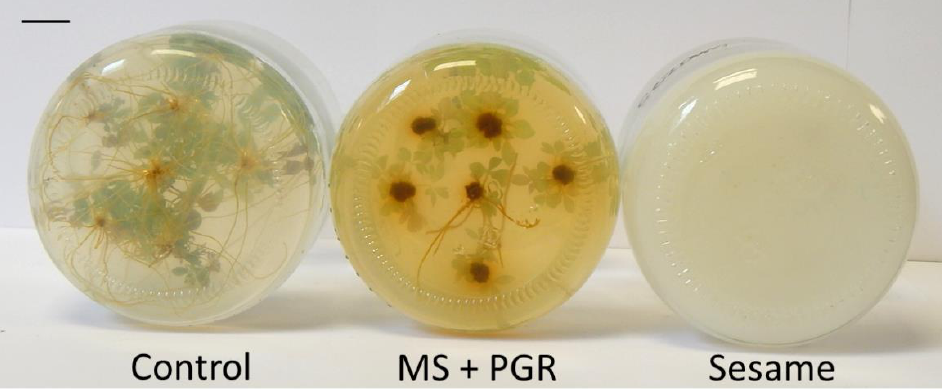
Figure 4. Influence of medium composition on the development of roots in L. spectabilis ‘White Gold’ after 10 weeks of culture; bar = 1 cm.